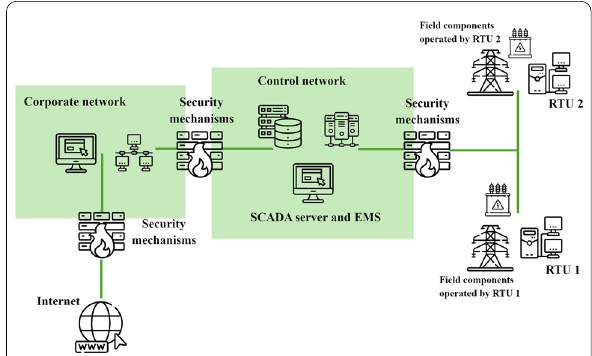
Fig. 1 Schematic overview over an electricity grid including its physi‑ cal and its cyber (SCADA)